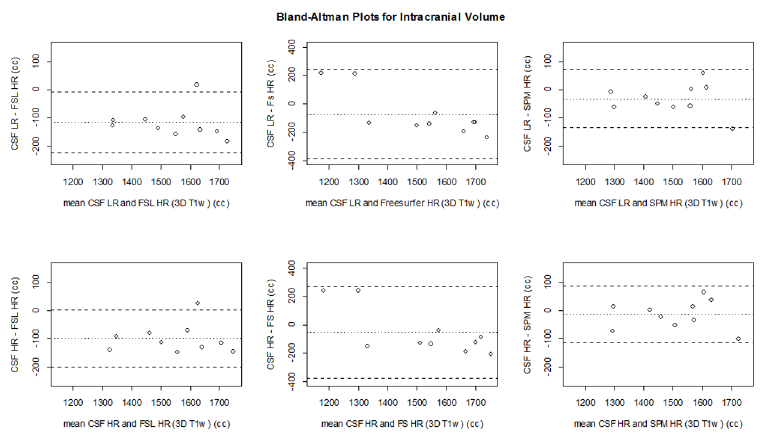
Fig 9. Bland Altman plots for the comparison of ICV between the CSF MRI sequences and the 3D T 1 -based brain segmentation methods. The dashed lines represent the limits of agreement (mean difference ±1.96 (cid:3) SD of the differences). CSF LR = CSF low resolution MRI scan; CSF HR = CSF high resolution MRI scan; FS = FreeSurfer.